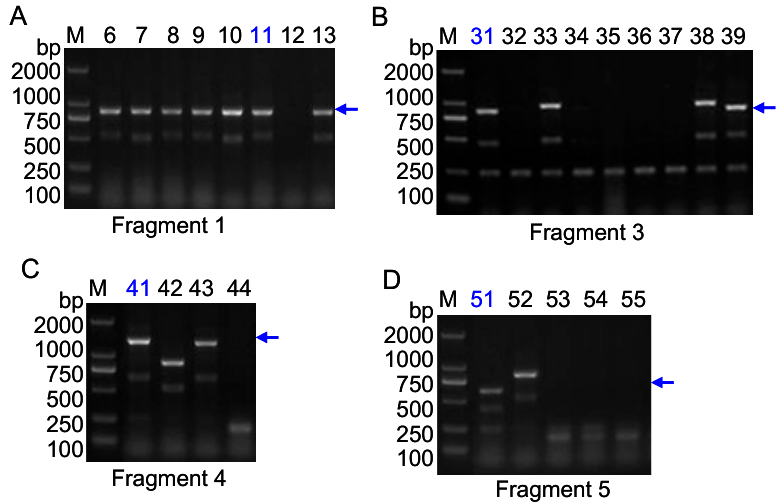
Figure 3. DNA cloning and identification of positive clones. ( A ) Clone identification of RAPD fragment 1. Lanes 6~12 indicate different clones; ( B ) Clone identification of RAPD fragment 3. Lanes 31~39 indicate different clones; ( C ) Clones identification of RAPD fragment 4. Lanes 41~44 indicate different clones; ( D ) Clone identification of RAPD fragment 5. Lanes 51~55 indicate different clones. The blue arrows indicate positive PCR products. Clones ZZH11, ZZH31, ZZH41 and ZZH51 in blue colors were sequencing. The blue arrows indicate expected PCR bands in size of different clones. Lane M indicates the DNA molecular weight marker DL2000 with the fragment size (bp).